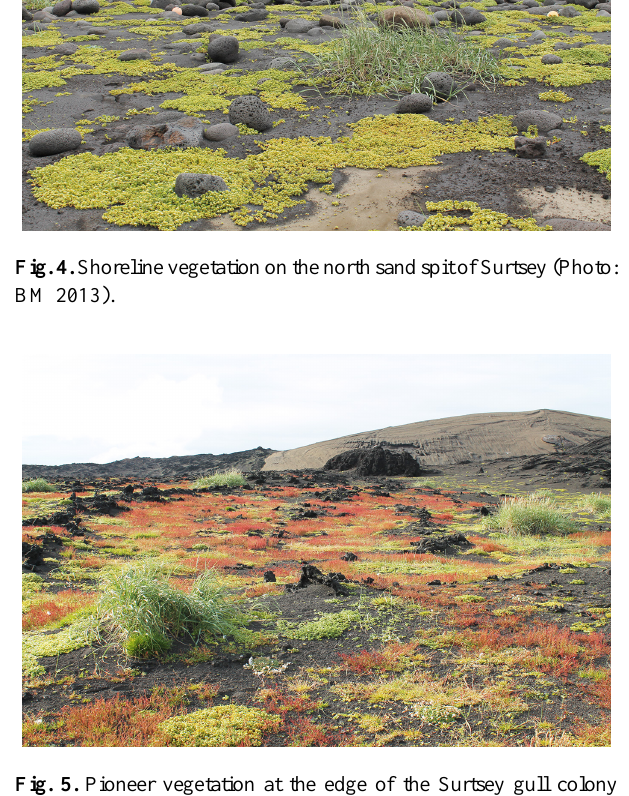
Fig. 5. Pioneer vegetation at the edge of the Surtsey gull colony (Photo: BM